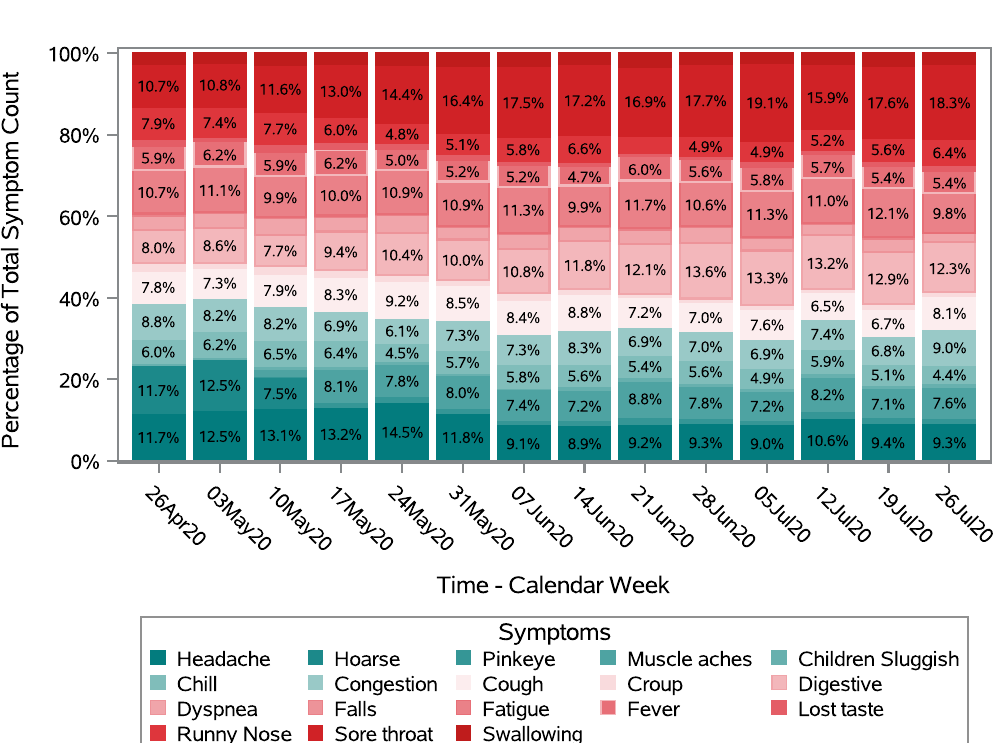
Figure 8. Percentage of respondents reporting COVID-19 related symptoms in FSA ‘N’